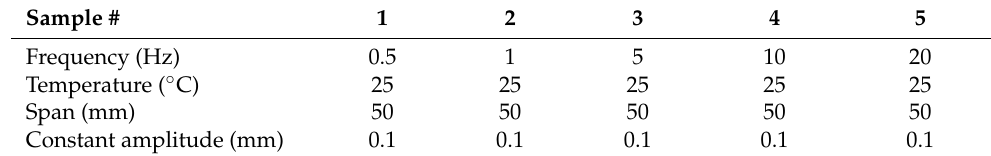
Table 3. Parameters adopted for the dynamic characterisation of S DMA